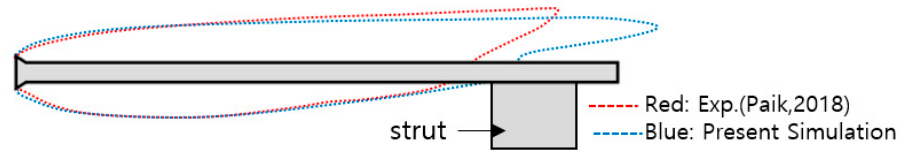
Figure 8. Cavitation formation at various ventilated rate coefficients (Fn = 10.8, Cq = 0.20).